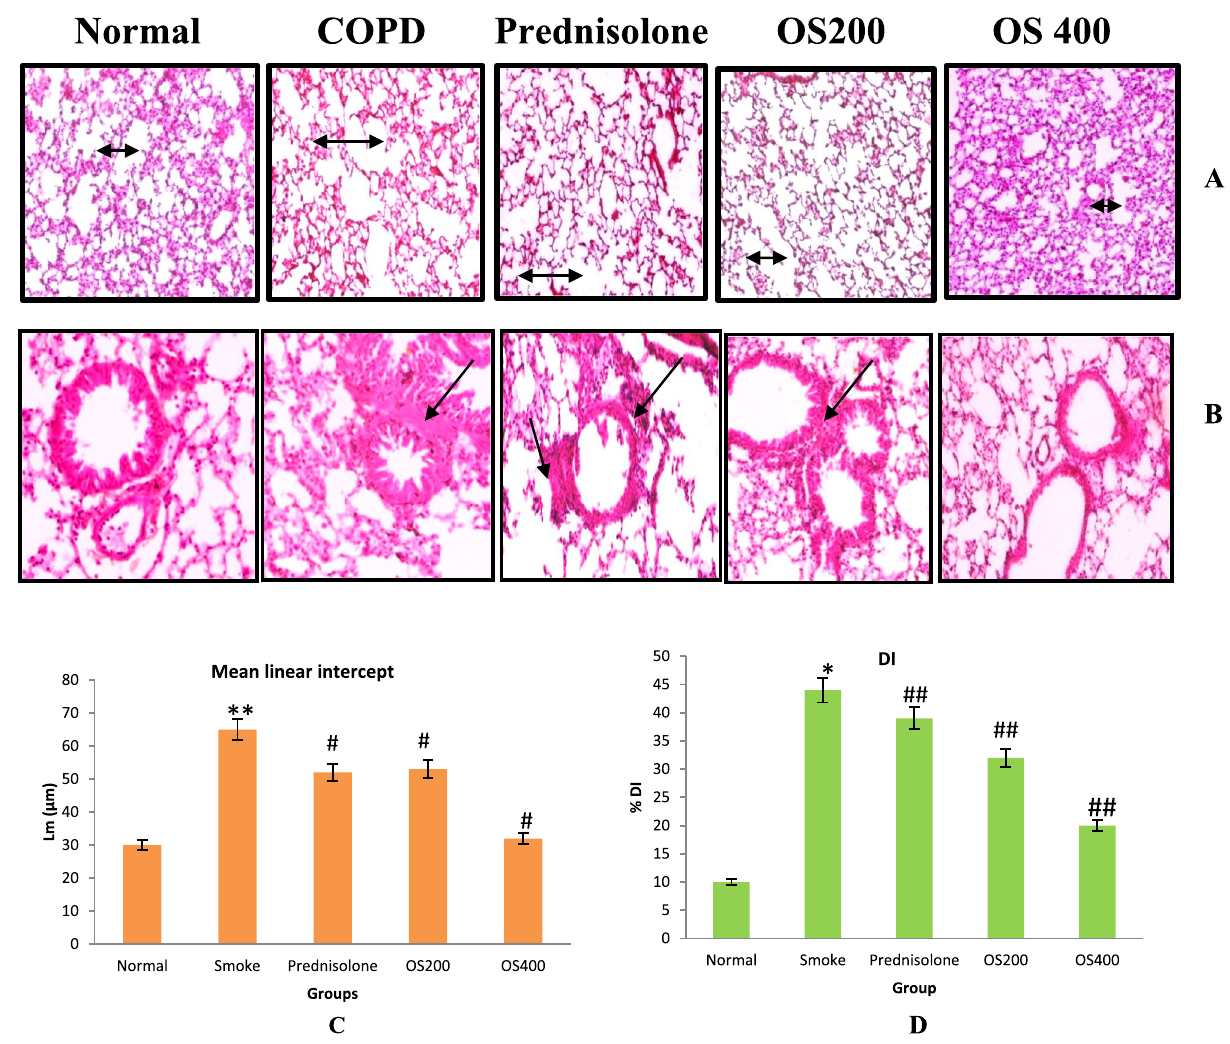
Figure 8. Micrograph of lung histopathology showing histological changes in lung segment stained with H&E after OLE treatment ( A,B ) Magnification X 100, Lm ( C ) and DI % ( D ). Control group showed no abnormalities and no destruction in the alveolar spaces and no peribronchiolar inflammation. COPD sections showed enlargement of the alveolar space with peribronchiolar inflammation. Prednisolone 1 mg/kg and OLE 200 mg/ kg represent minor improvement in the airway enlargement and peribronchiolar inflammation while OLE 400 mg/kg effectively altered the alveolar spaces with no destruction and inflammation. The Lm (C) and DI (D) also exhibited improvement by OLE treatment in CS exposed mice. Values are expressed as mean ± SEM. Results were analysed statistically by one way ANNOVA followed by Turkey’s test. *p < 0.01 and **p < 0.05 versus the normal group; # p < 0.01 and ## p < 0.05 versus the COPD group. Double headed arrow ( ↔ ) shows alveolar enlargement; single headed arrow ( → ) shows peribronchiolar